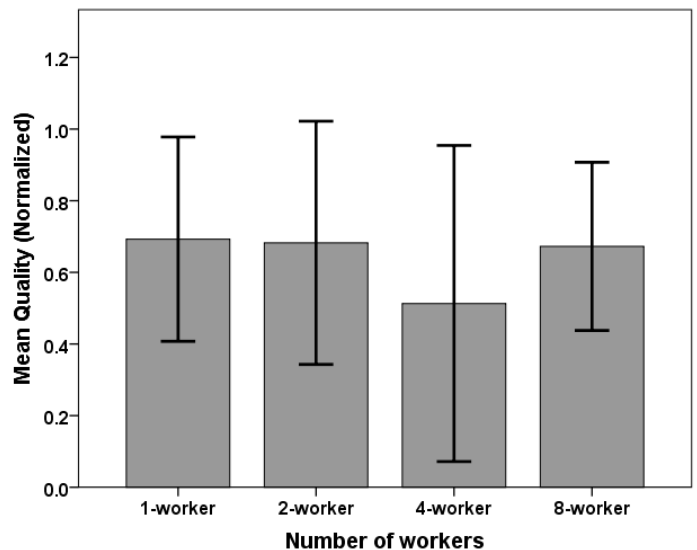
Figure 6. Dialogue quality: no significant difference in quality scores between all